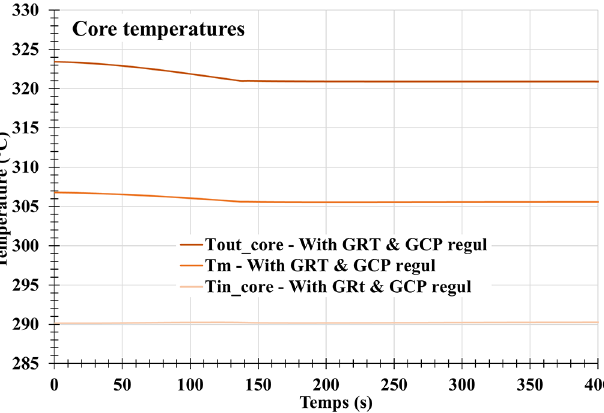
Fig. 4. Temperatures in the core (inlet Tin_core, outlet Tout_core and average Tm) during a load following transient.